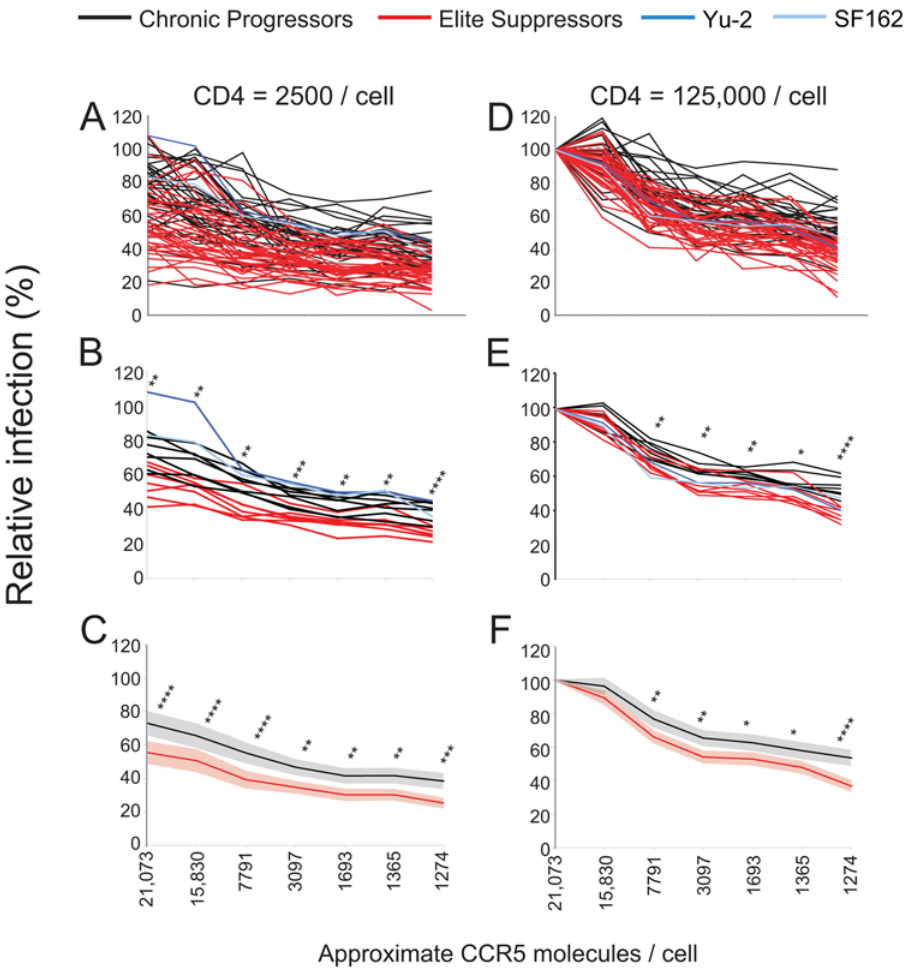
Figure 3. ES clones show reduced entry efficiency at fixed CD4 surface concentrations. (A–C,D–F) Affinofile cells were induced to express threshold (approximately 2,500) CD4 molecules/cell (A–C) or maximal (approximately 125,000) CD4 molecules/cell (D–F) and CCR5 molecules ranging from approximately 1274 to 21,073 molecules/cell prior to infection. Infection is performed as described in Figure 2. (B,E) Infectivity of clones from individuals were averaged and plotted as a single line for chronic and ES individuals. P values are given for patient averages. (n=7) (C,F) Average of all individual chronic or elite env clones at threshold (C) and maximal (F) CD4 concentrations with CCR5 concentrations ranging from approximately 1274 to 21,073 molecules/cell. P values are represented as follows: P , .05 (*), P , .01 (**), P , .001 (***), P , .0001 (***). 95% confidence intervals are shown for chronic (grey) and ES (pink).